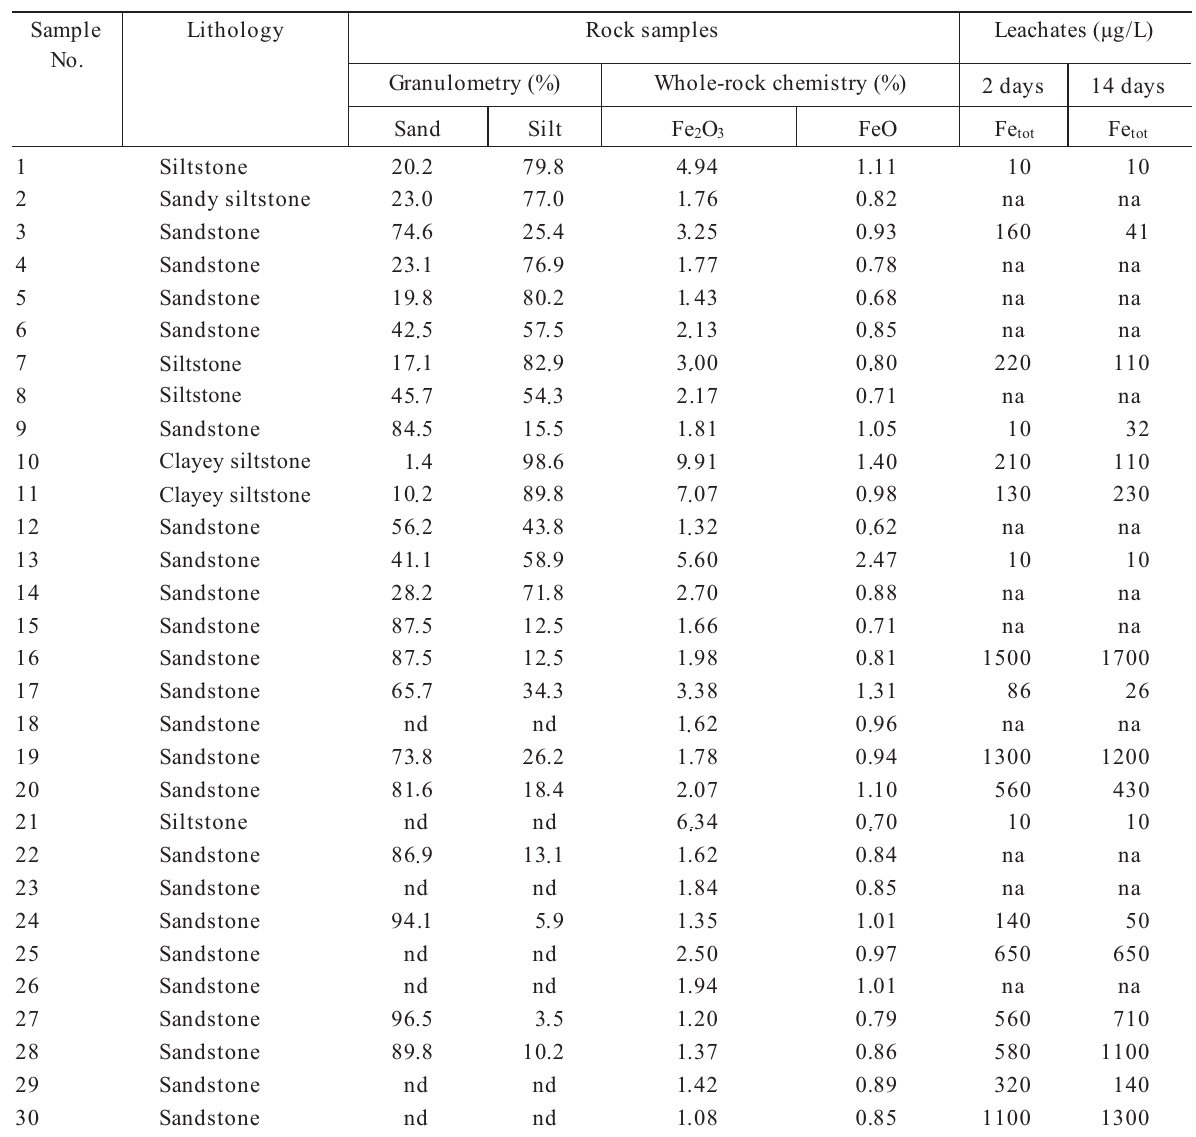
Table 3. The granulometric composition, contents of Fe 2 O 3 and FeO in aquifer­forming rocks and the leached Fe tot concentrations in solutions after 2 and 14 days of leaching experiments. The numbering of the rock samples is in accordance with Table 1. na, not analysed; nd, no